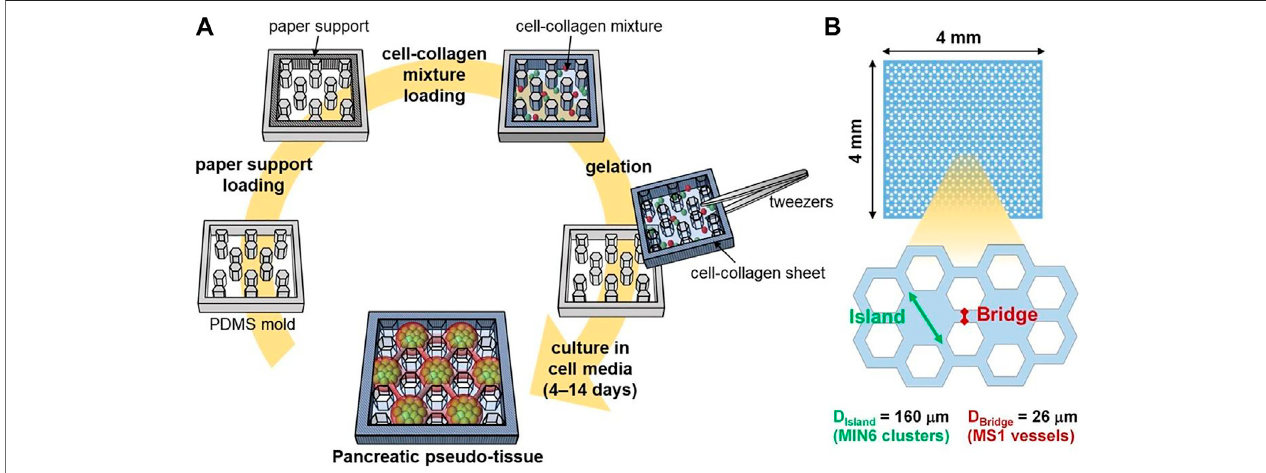
FIGURE 6 | (A) The procedure of preparation of micro-patterned collagen sheet as a pancreatic pseudo-tissue and (B) dimensions of hexagonal micro-pattern (Seo et al., 2020).